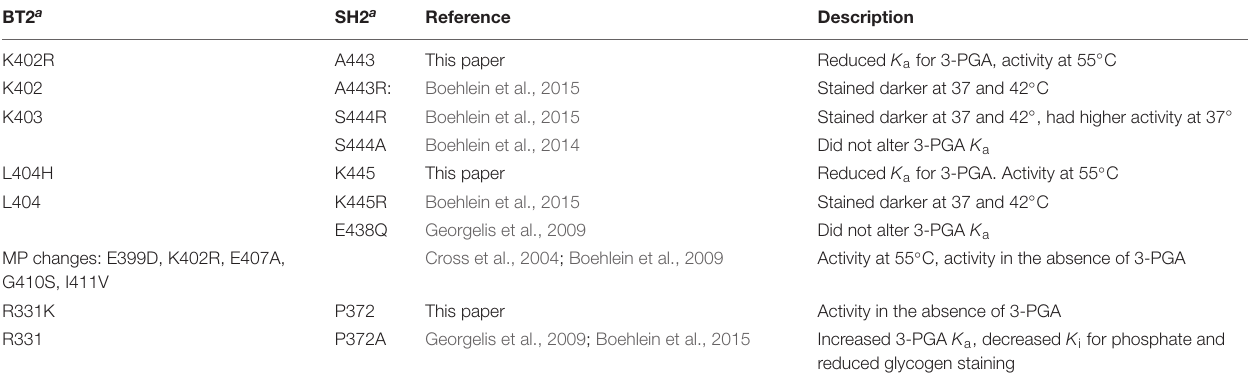
TABLE 7 | Mutants located in or associated with the G α G domain.